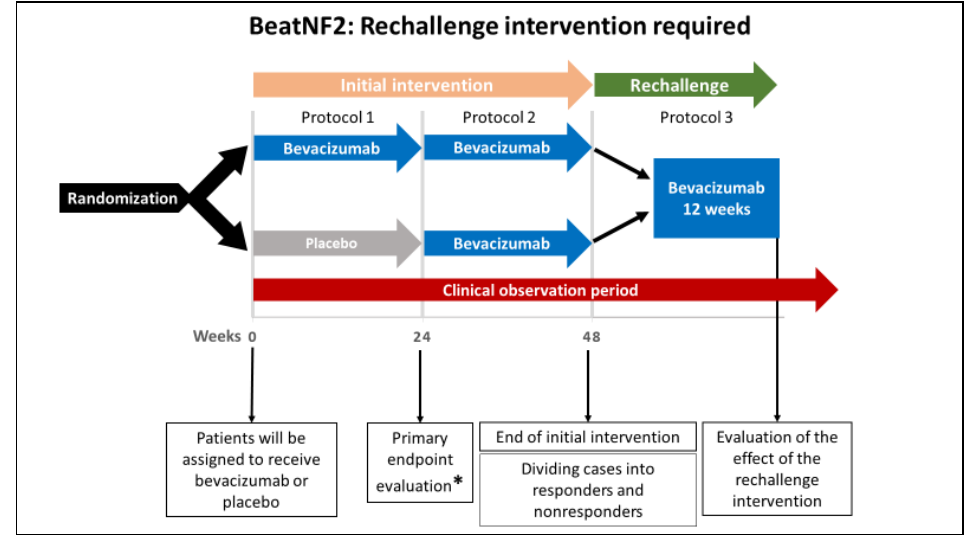
Figure 3. A schematic illustration of rechallenge intervention in the BeatNF2 trial. Patients